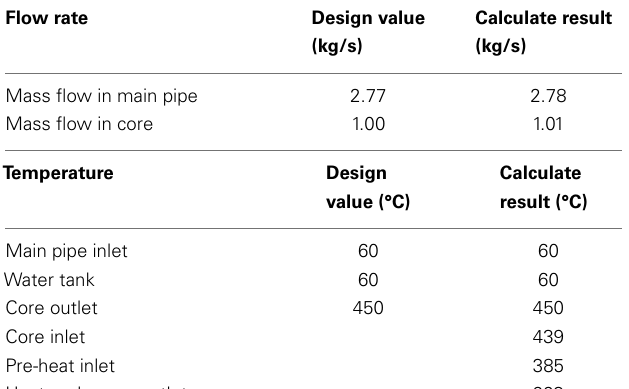
Table 1 | Comparison of the steady parameters between design values and calculate results .